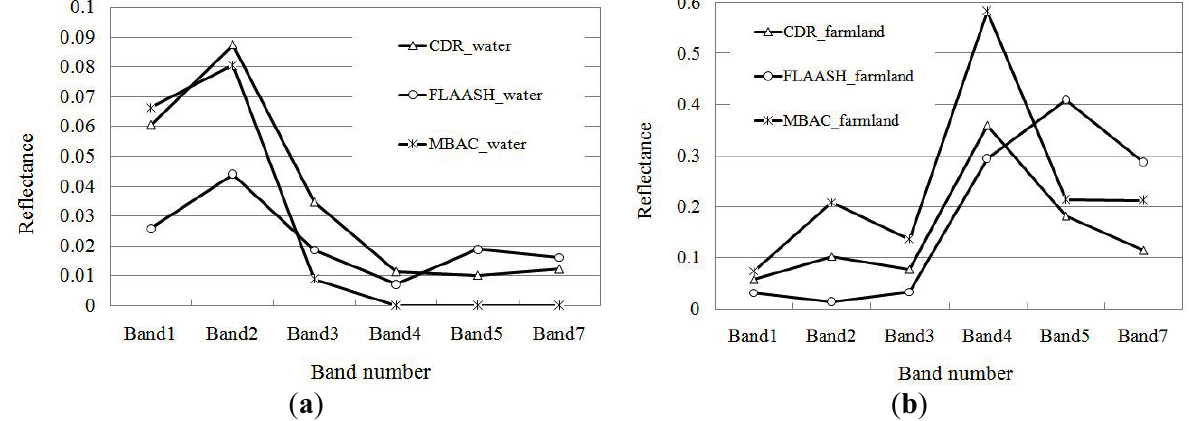
Figure 7. The spectra of the MBAC compared with the FLAASH and Landsat CDR in flat areas: ( a ) water pixel; and ( b ) farmland